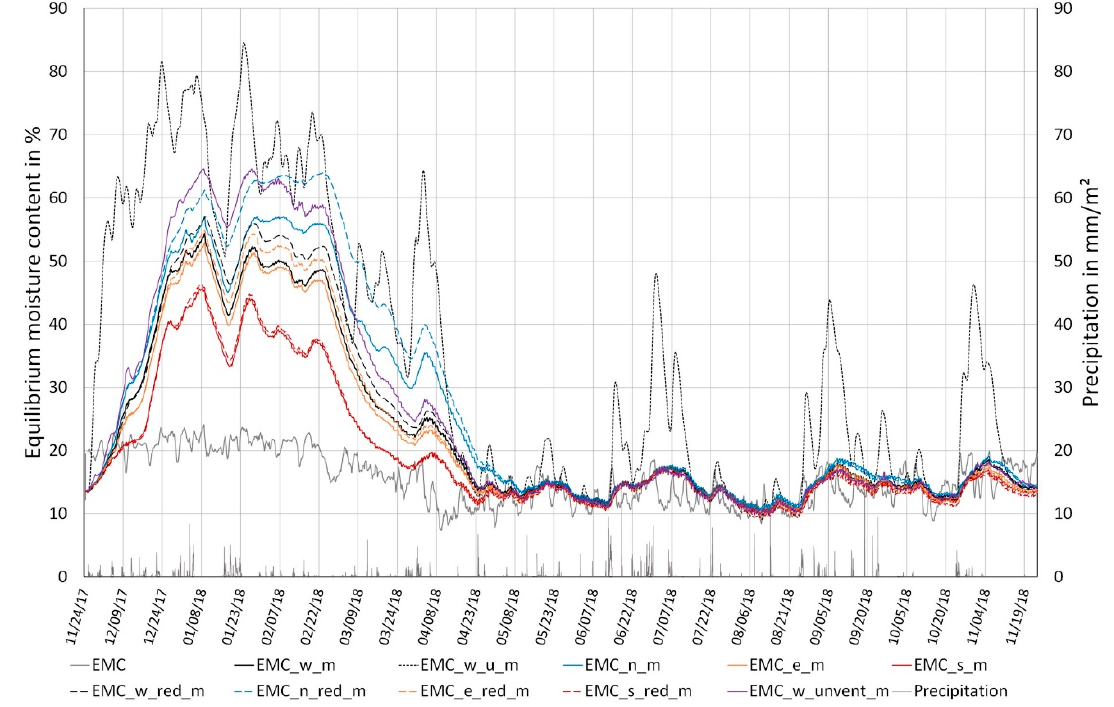
Figure 9. Moisture content of the lower and upper shingle layer.